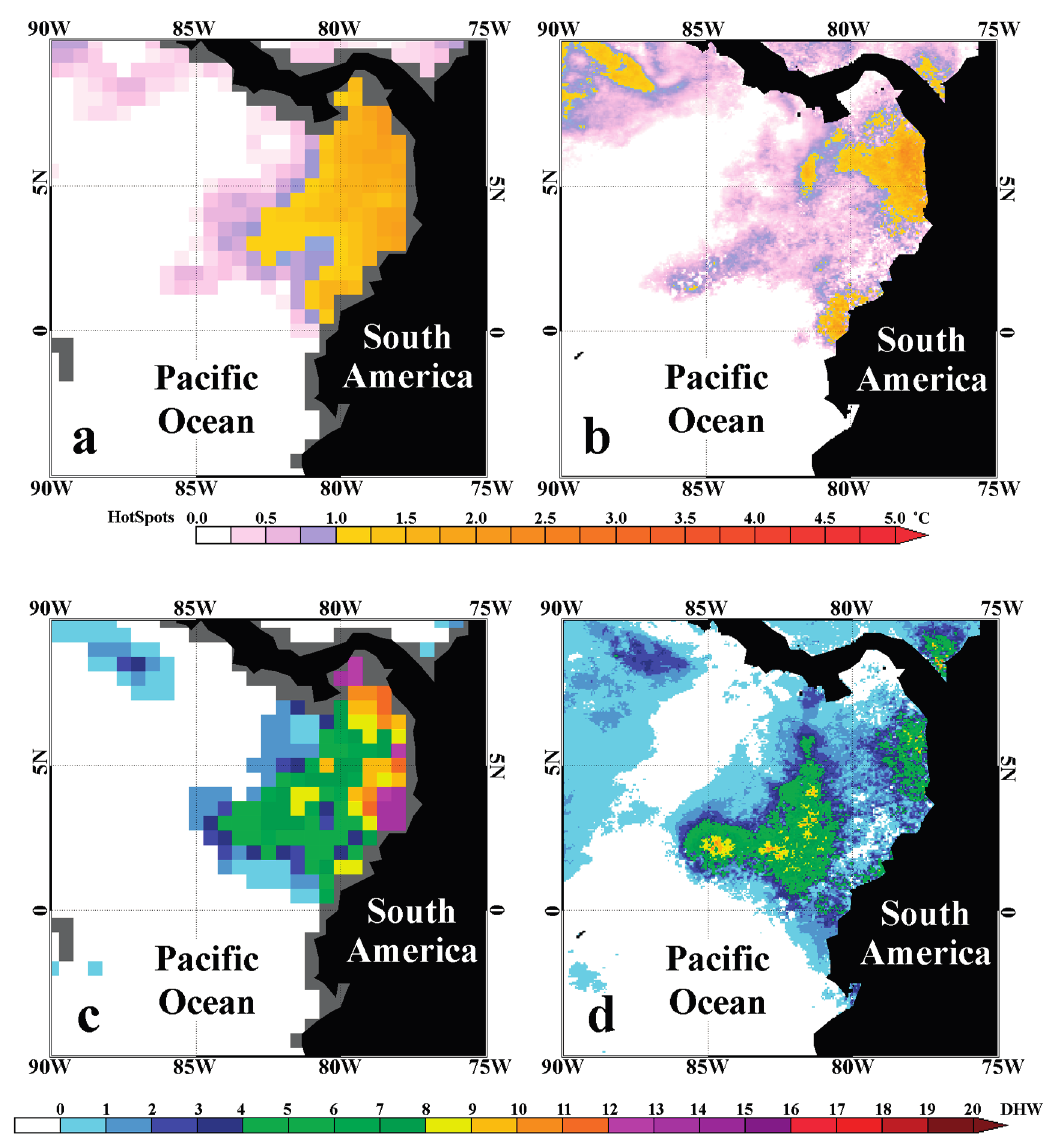
Figure 6. CRW’s twice-weekly 50-km Coral Bleaching HotSpots product ( a ) and daily global 5-km Coral Bleaching HotSpots product ( b ) of 9 May 2013, for the Gulf of